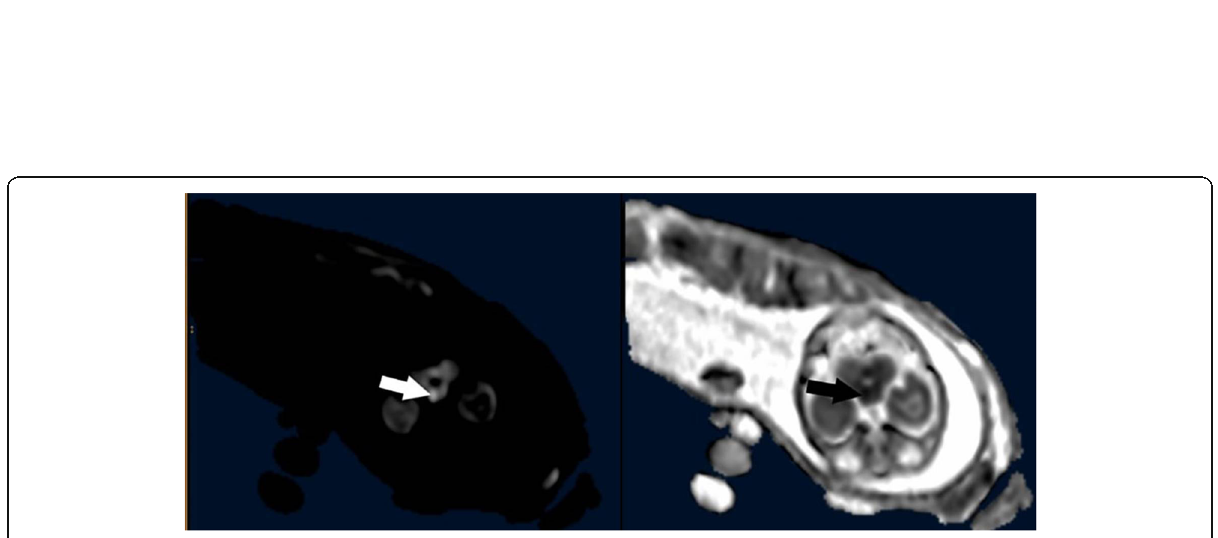
Fig. 4 Fetal MRI at 28 weeks 4 days — DWI and ADC maps of brain: Focus of restricted diffusion in the right hemipons with drop in signal intensity on corresponding ADC maps, represents a possible acute ischemic